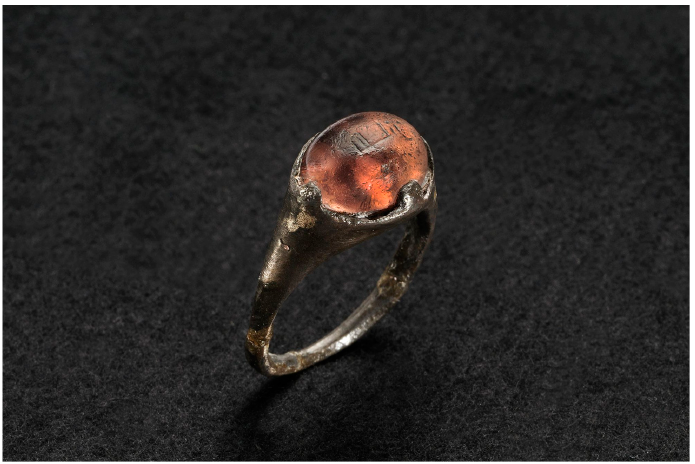
Figure 4. Kufic “All ā h” Finger ring ©Gabriel Hildebrand, Swedish History Museum (CC BY 2.5 SE license).